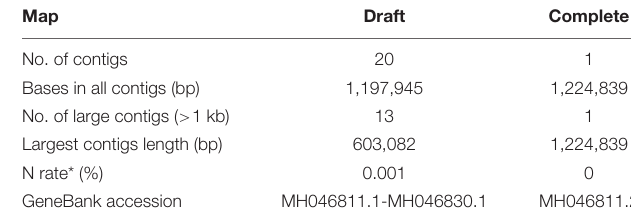
*N rate: percentage of uncertain